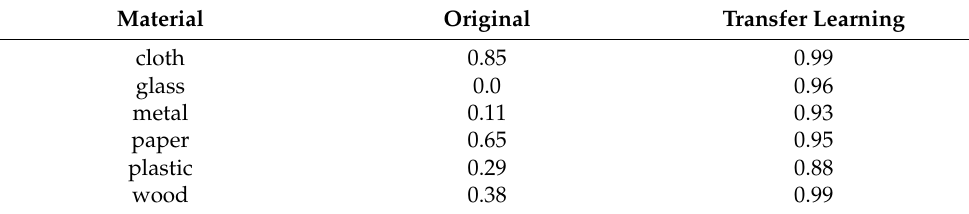
Table 4. Recognition results.